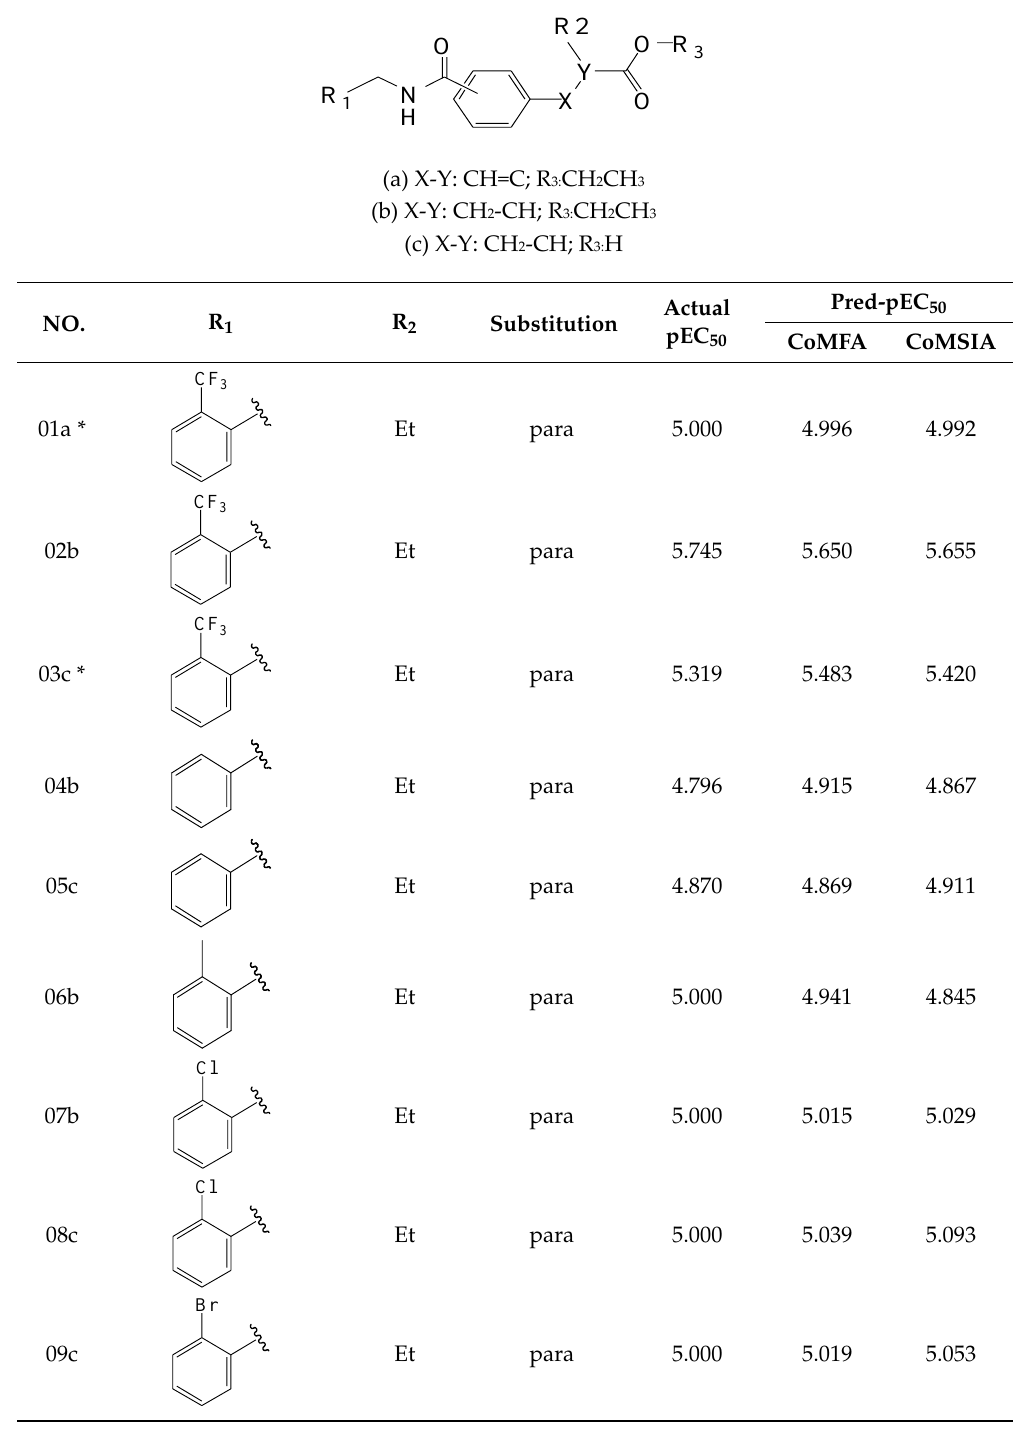
Table 3. Actual and predicted pEC 50 values of PPARγ agonists.